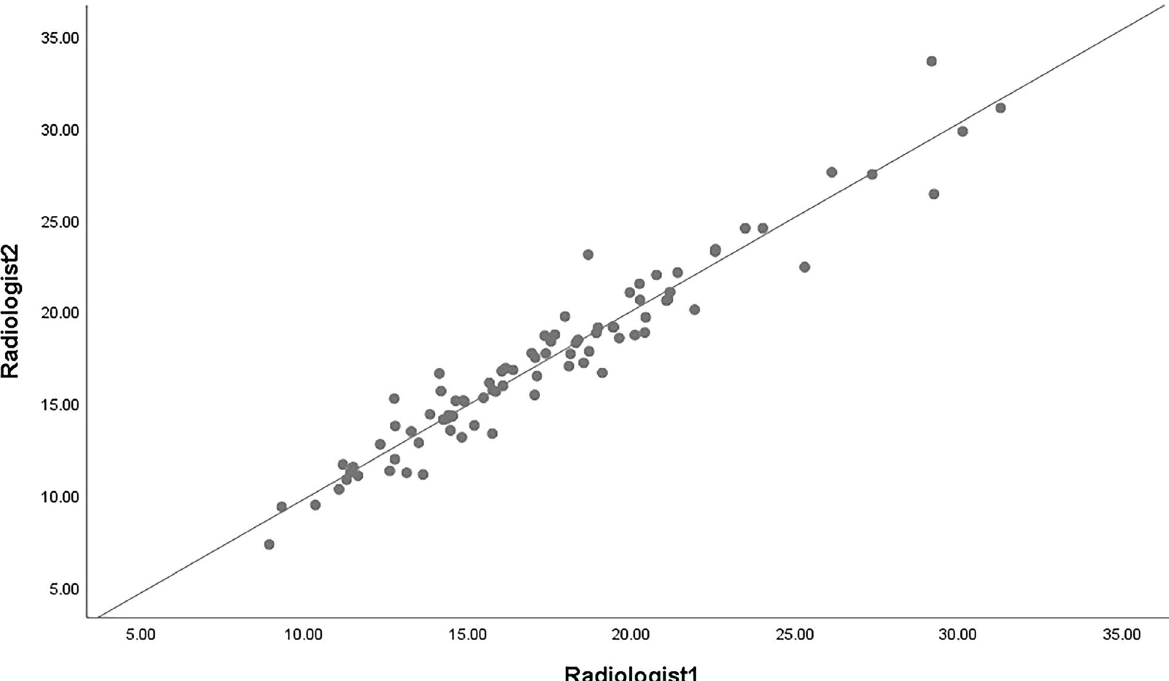
Fig. 2 Scatter diagram of iodine quantification by two radiologists